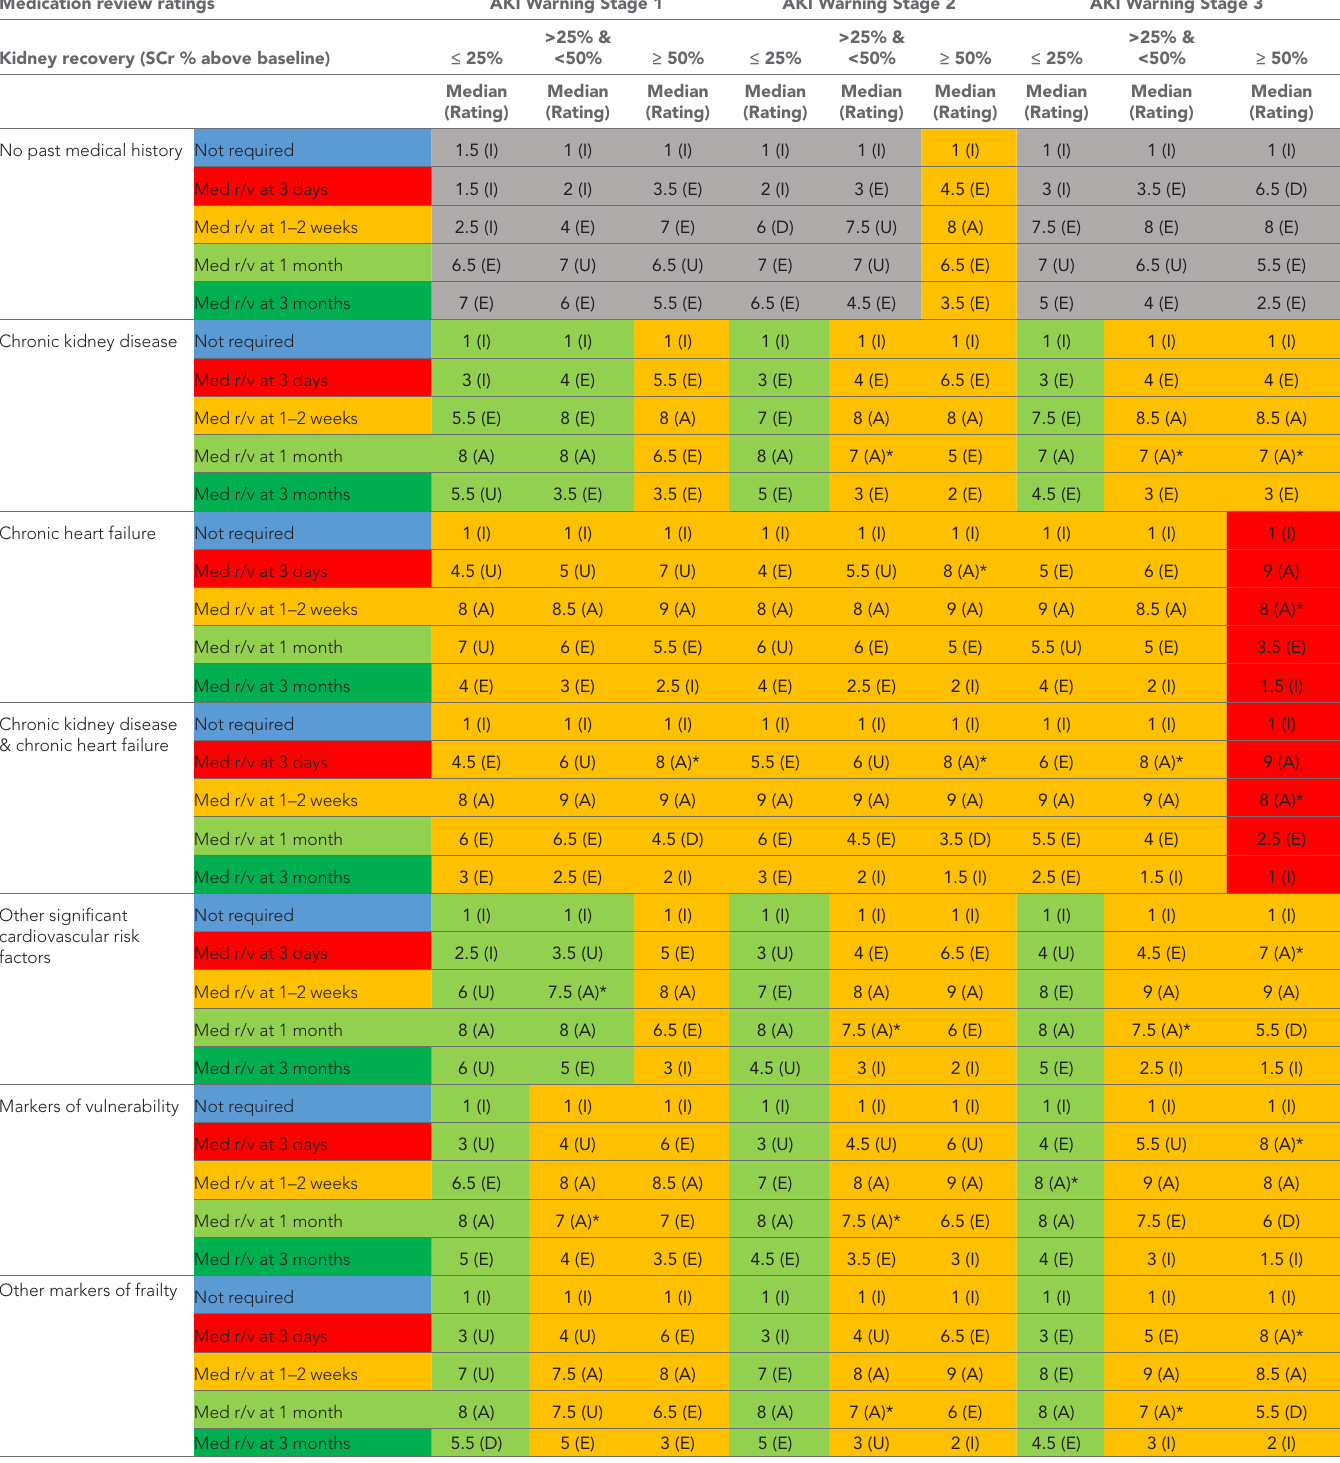
Table 3 Summary of timeliness for performing the first post- discharge medication review. Medication review